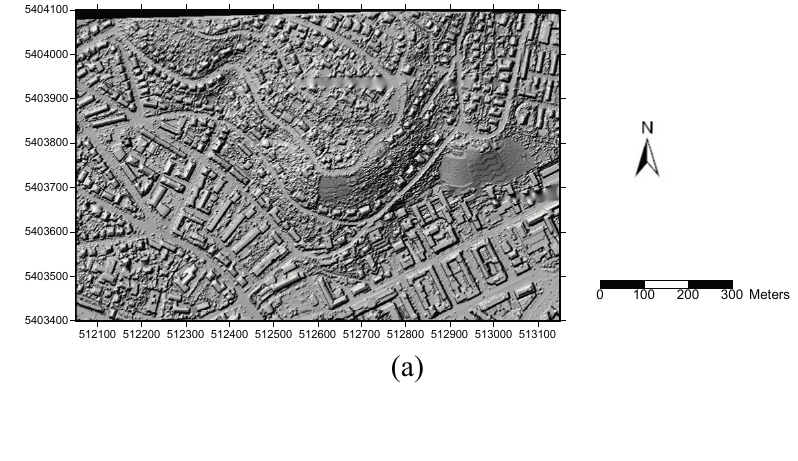
Figure 4. Filtering results of the proposed method for the test data of Site 1: ( a ) DSM generated from the raw point cloud; ( b ) three-dimensional view of the DSM; ( c ) nonground points extracted by filtering; ( d ) ground points extracted by filtering; ( e ) DEM generated from the ground